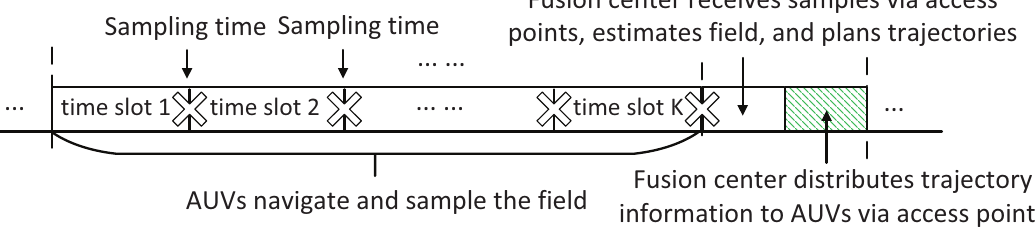
Figure 2. System operation within an epoch. The AUV samples at the end of each time slot. There are K time slots within an epoch for AUV navigation and